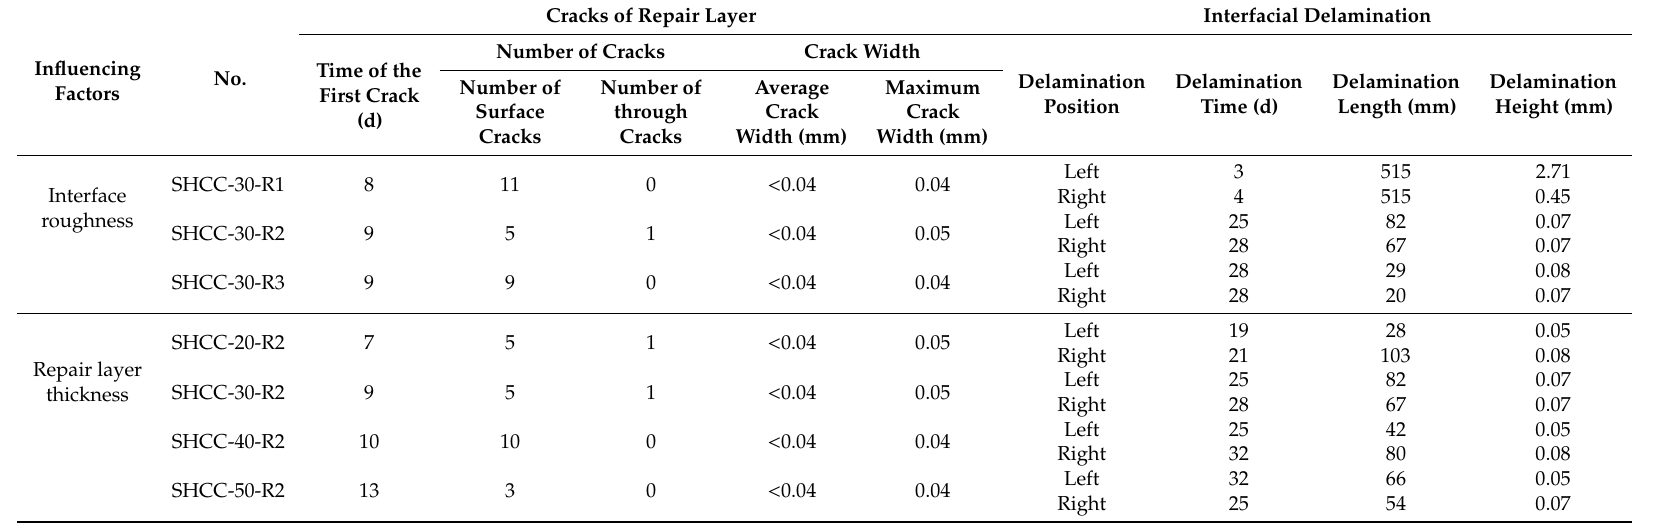
Table 7. Crack formation and interfacial delamination of SHCC-repaired concrete